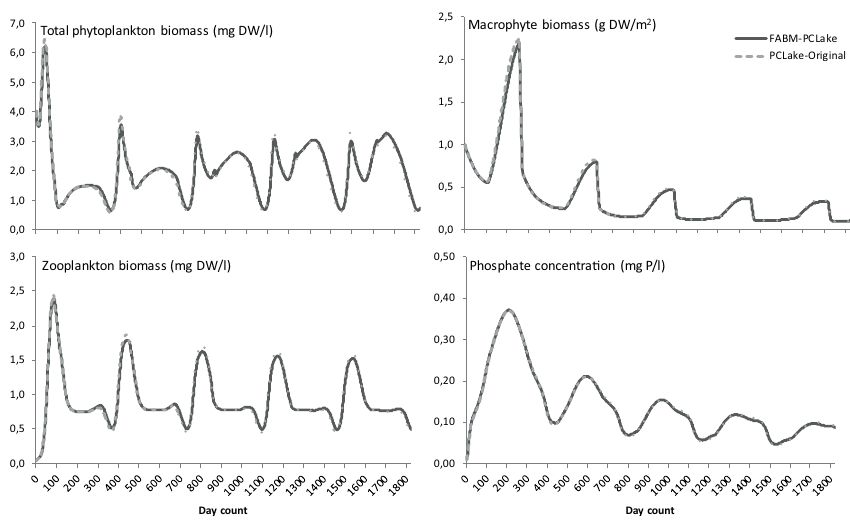
Figure 3. Key time series outputs from a 5-year simulation by the original PCLake model (PCLake-Original), and the new FABM-PCLake model (FABM-PCLake), represented by dry weight of total phytoplankton biomass, dry weight of zooplankton biomass, dry weight of macrophytes biomass, and the concentration of phosphate in the water